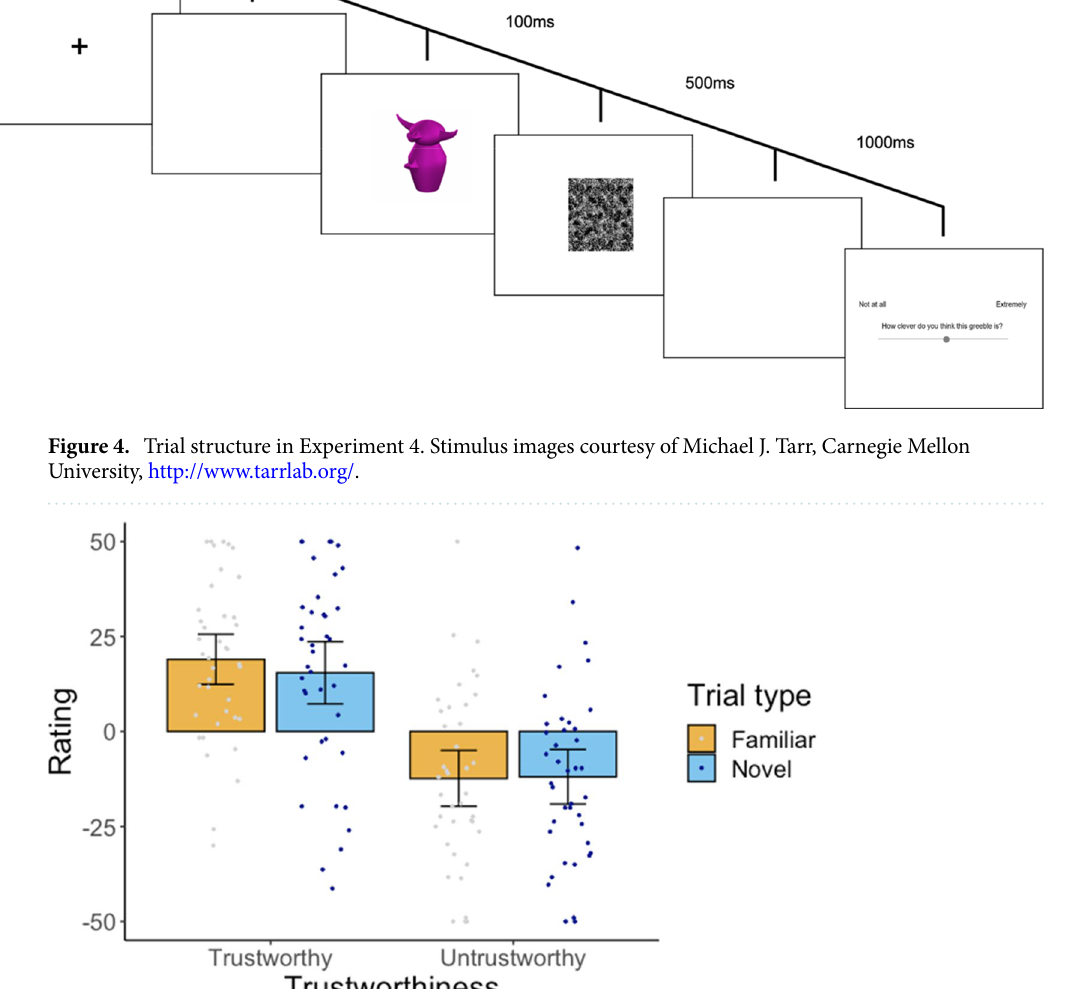
Figure 5. Results from Experiment 4. Error bars represent 95% confidence intervals around the